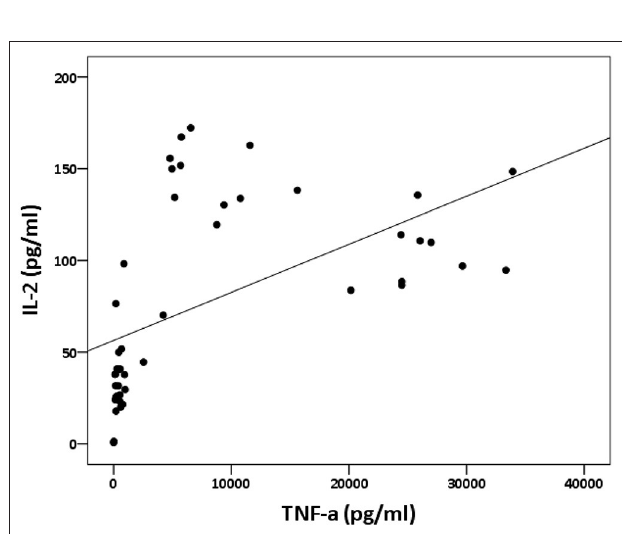
FIGURE 2 | Relation between IL-2 and TNF- α concentration in vitro . The panel depicts the levels of IL-2 (shown on the y-axis) and the levels of TNF- α (shown on the x-axis). The data between the concentration of IL-2 and TNF- α in vitro is a proportional correlation ( p < 0.000; rs = 0.74).